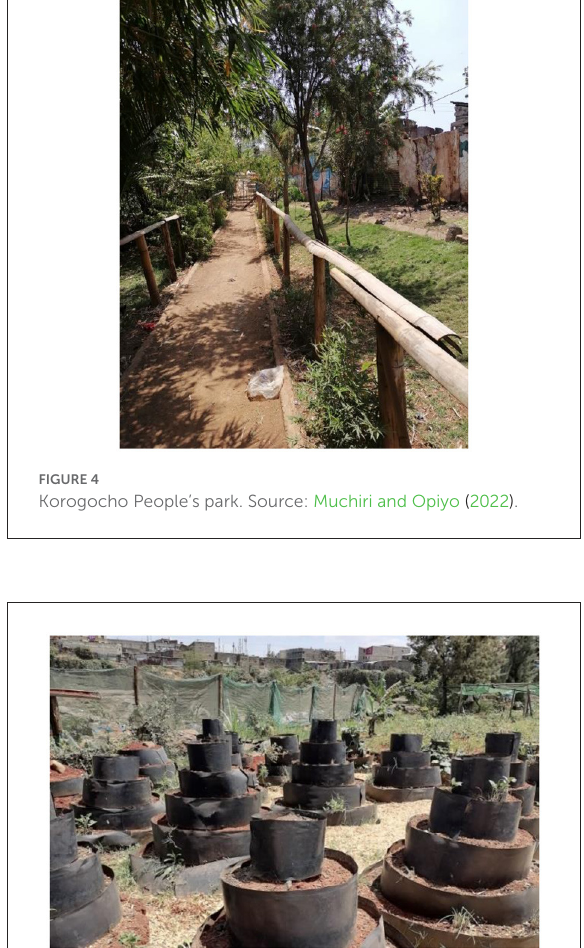
FIGURE5 Sustainable urban farming practices for food security in Korogocho. Source: Muchiri and Opiyo